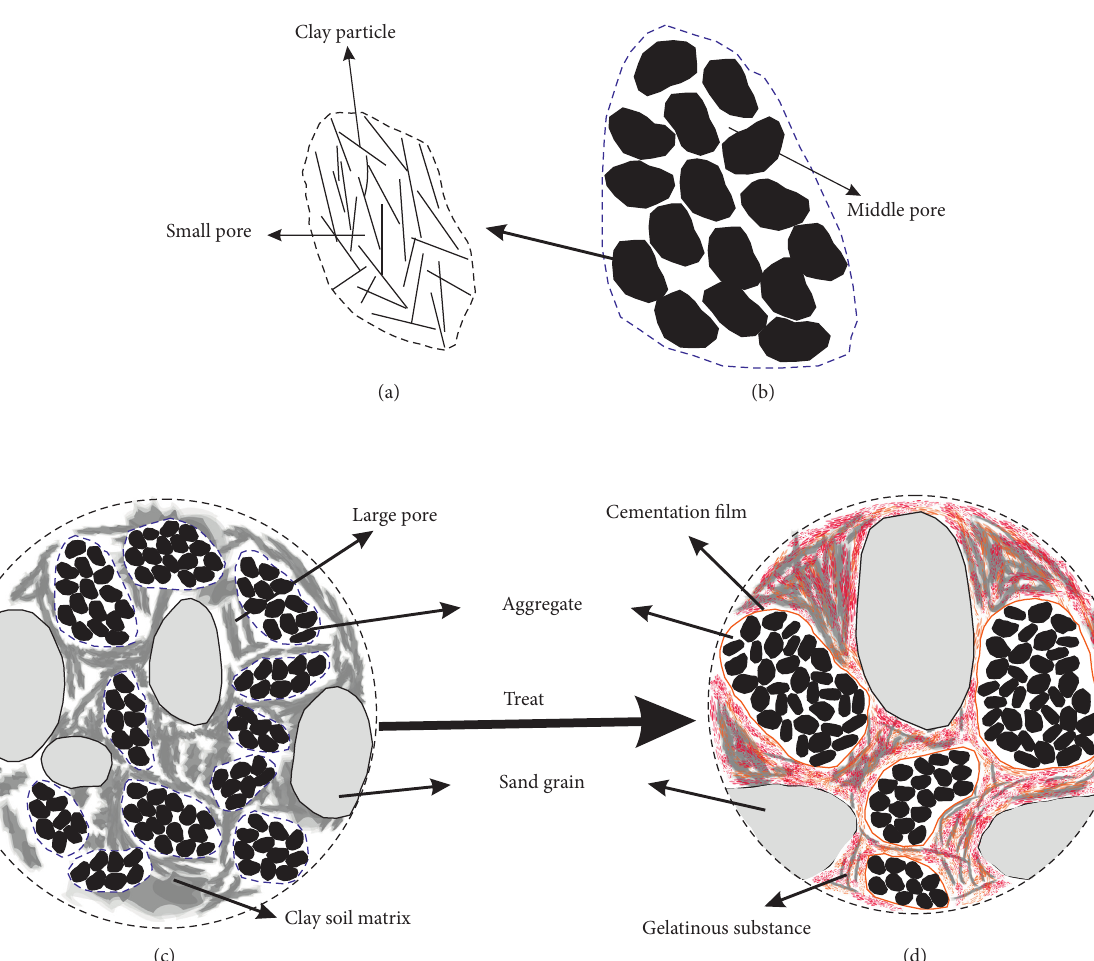
Figure 8: Structure of flocculated fabric (a), aggregate (b), raw soil (c), and improved soil